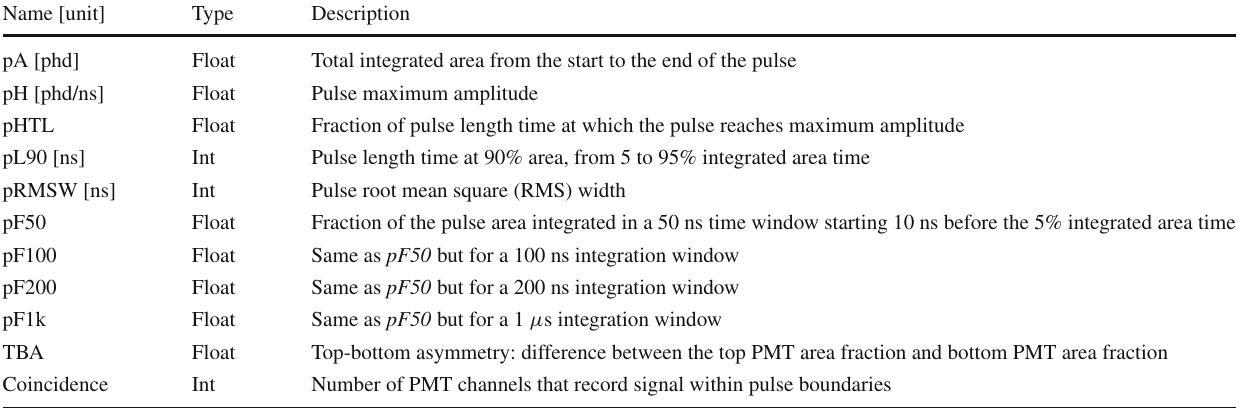
Table 1 Some of the pulse-level RQs available in LZ simulated data chosen for the classification analysis in this work